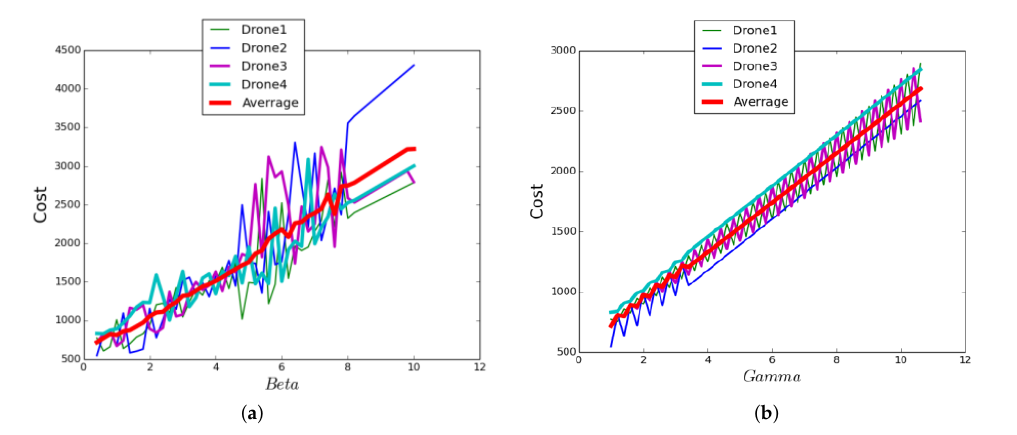
Figure 9. Impact of the delay and data collection rate on the total cost. ( a ) Variation of the cost with respect to the delay ( β ); ( b ) variation of the cost with respect to the data collection rate.